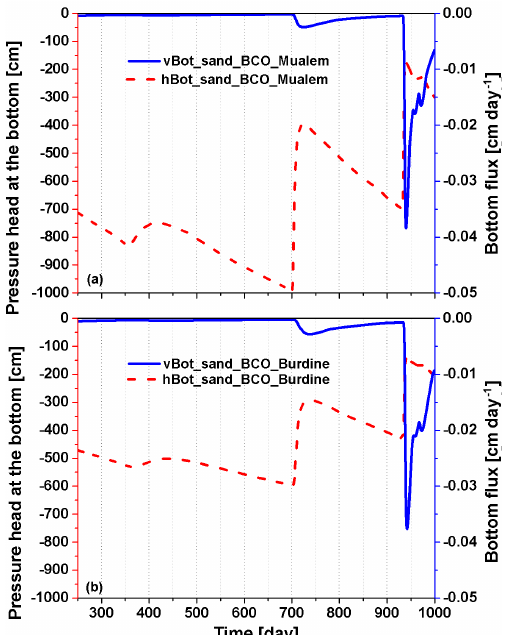
Figure 12. As in Fig. 10, but for the BCO parameterization (see Table